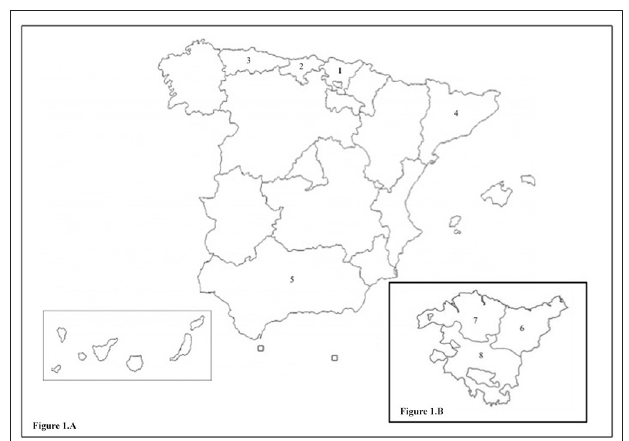
FIGURE 1 | (A) Map of Spain. 1. Basque Country. 2. Cantabria. 3. Asturias. 4. Cataluna. 5. Andalucia. (B) Enlarged map of the Basque Country with its provinces. 6. Gipuzkoa. 7. Bizkaia. 8. Araba..